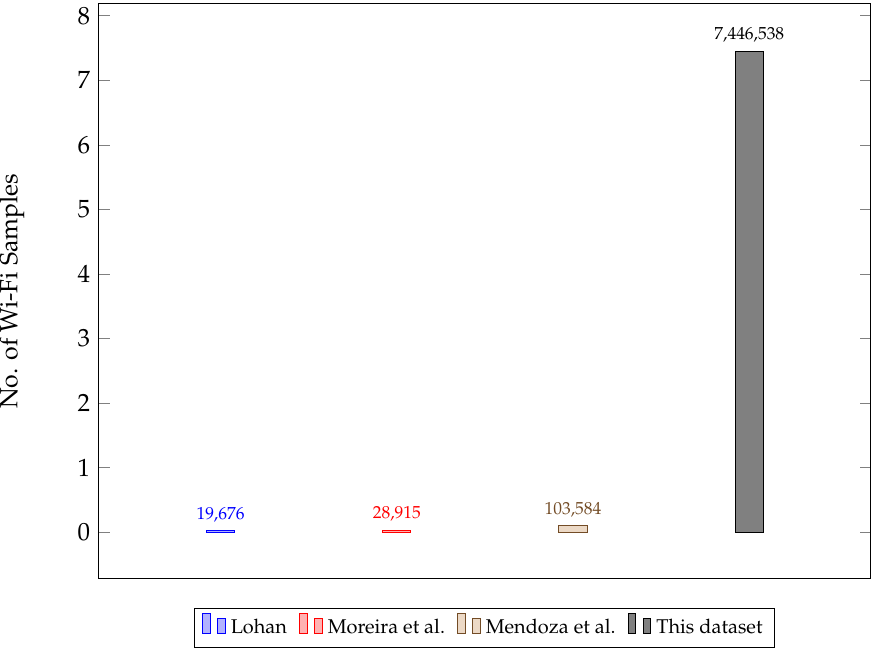
Figure 6. Comparison between the sizes of different Wi-Fi fingerprinting datasets.